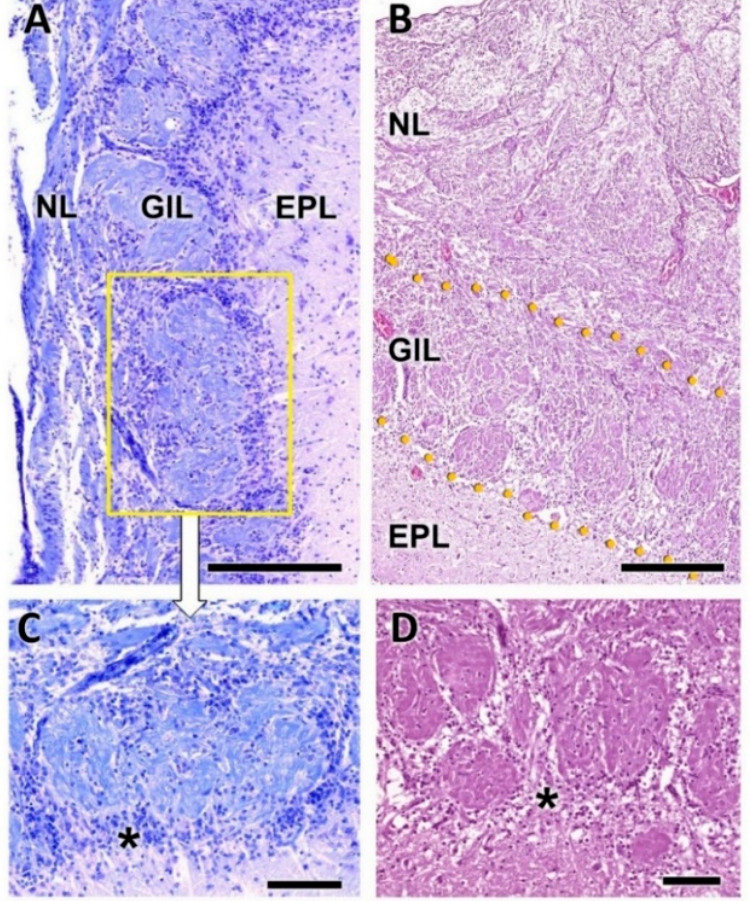
Figure 4. Histological study of the superficial layers of the olfactory bulb of the dog. ( A ) Nissl staining of the nerve layer (NL), glomerular layer (GlL) and external plexiform layer (EPL). ( B ) Hematoxylin–eosin staining. The GlL is outlined by yellow dots. ( C ) Enlargement of the box in ( A ), showing the periglomerular cells (*) concentrated in the border between the glomeruli and the EPL. Nissl staining. ( D ) Similar image of the glomerular layer stained by hematoxylin–eosin. Scale bars: ( A , B ): 250 µ m; ( C , D ): 100 µ m.